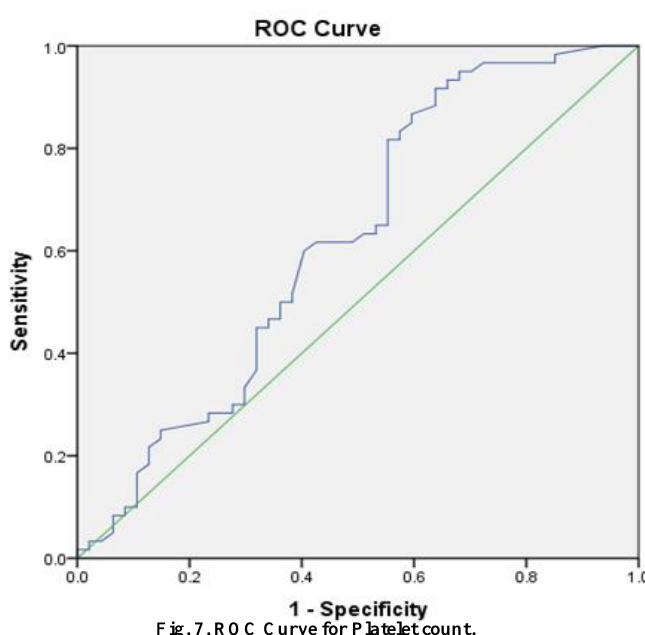
Fig. 7. ROC Curve for Platelet